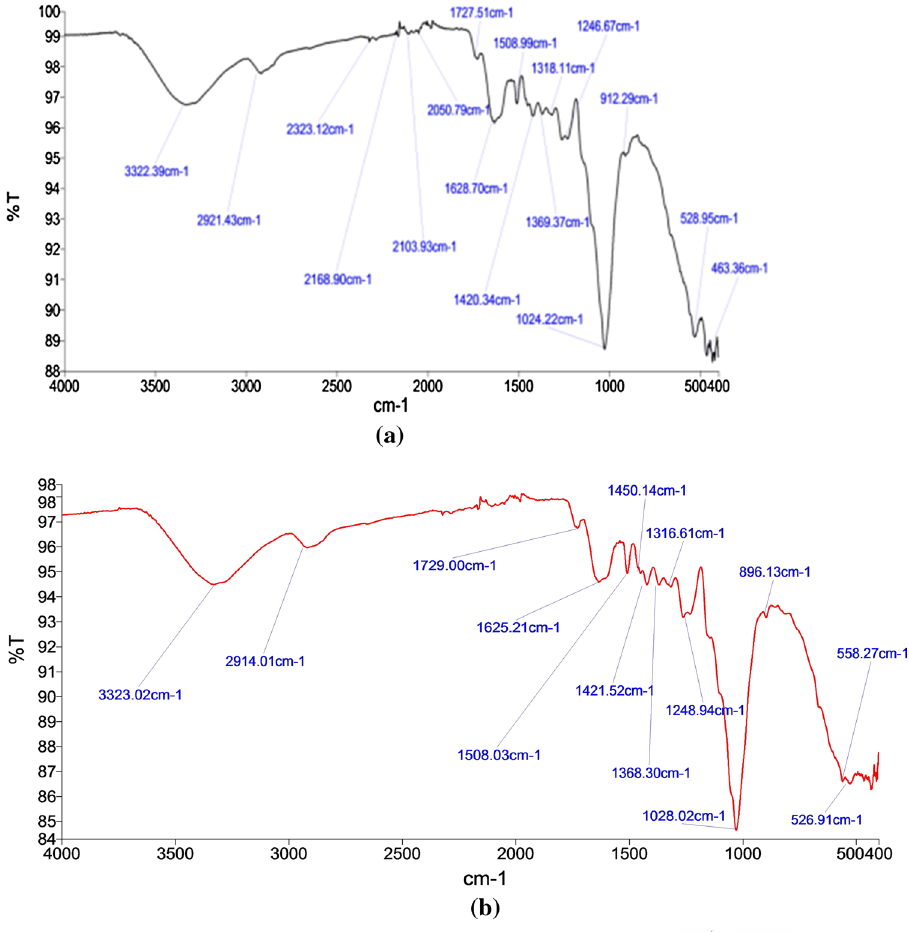
Fig. 1 FTIR spectra of ground- nut shell before ( a ) and after ( b ) adsorption of Cr(VI)